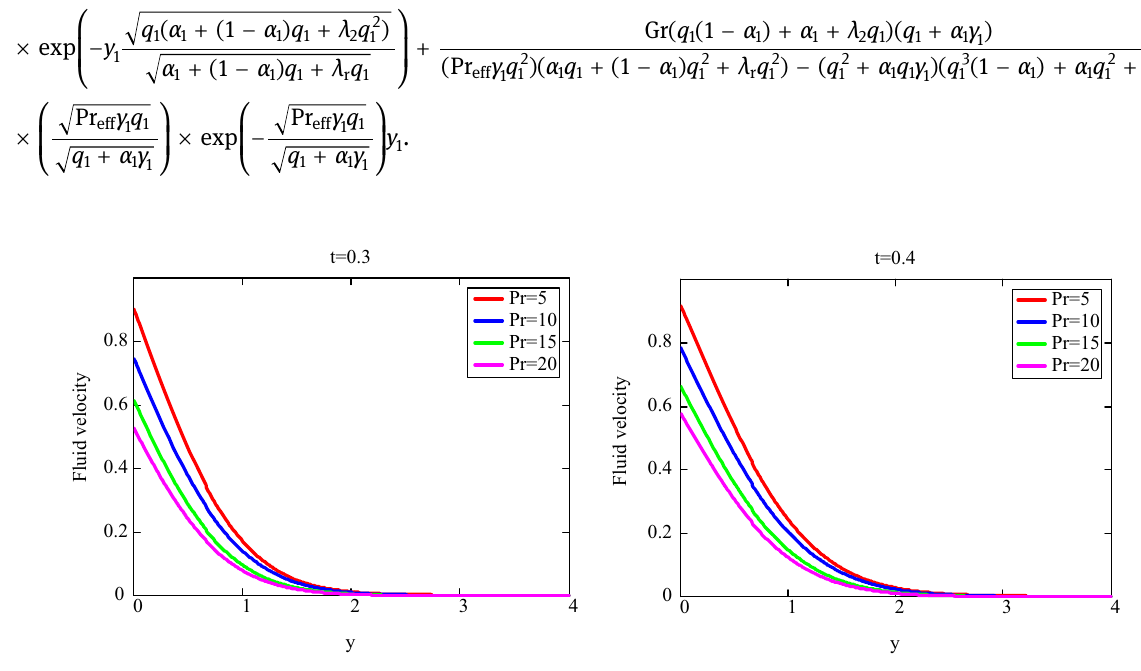
Figure 2: The velocity pro fi le with di ff erent dimensionless Prandtl numbers at di ff erent times.